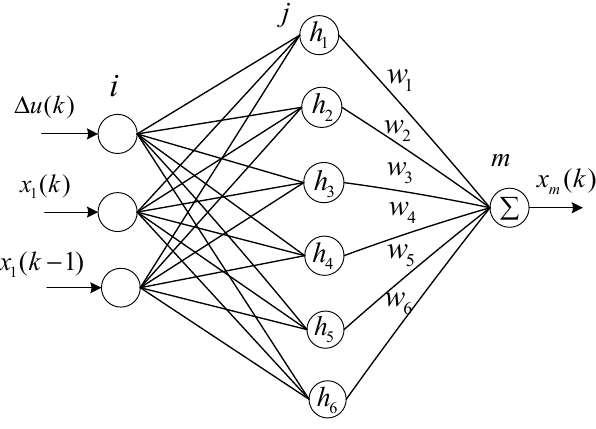
Figure 16. Structure of the three layers of the RBF neural network.